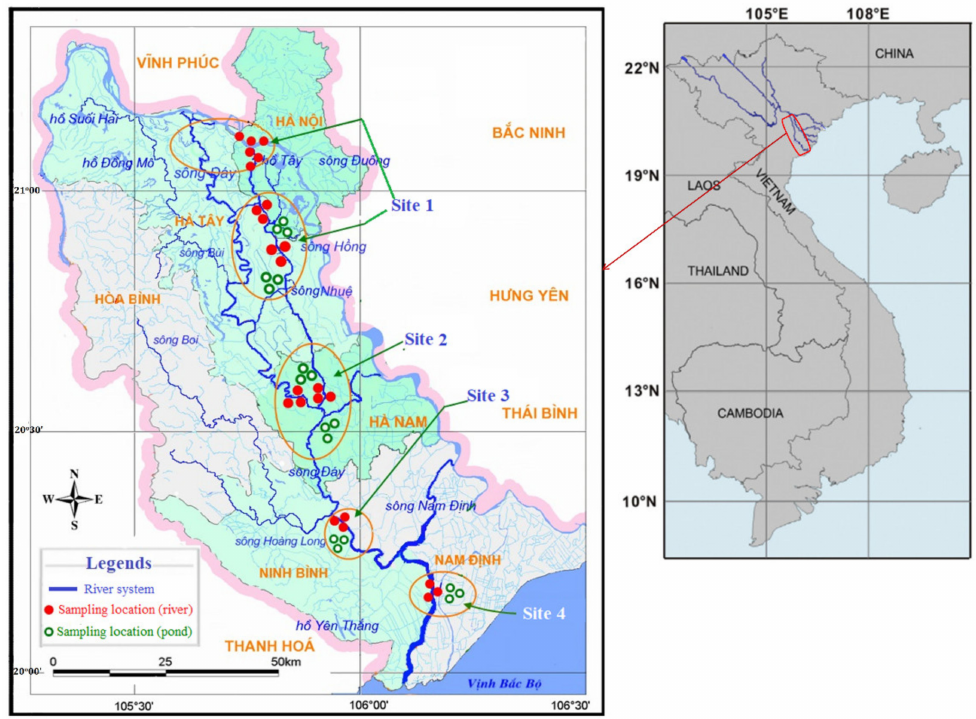
Figure 1. The study area map depicts the Nhue–Day River basin as well as sampling locations. Closed red dots represent river sampling locations, while open green dots represent aquaculture pond